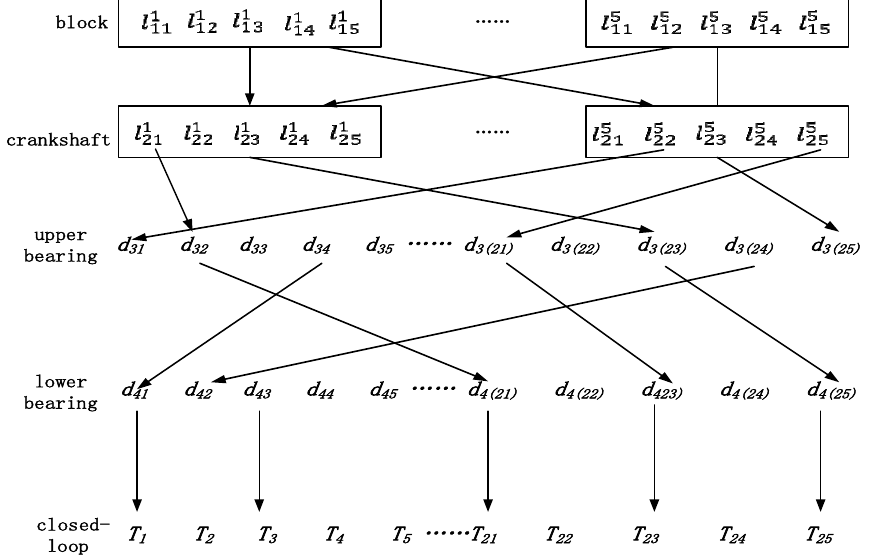
Figure 4. Crank assembly selection process structure.